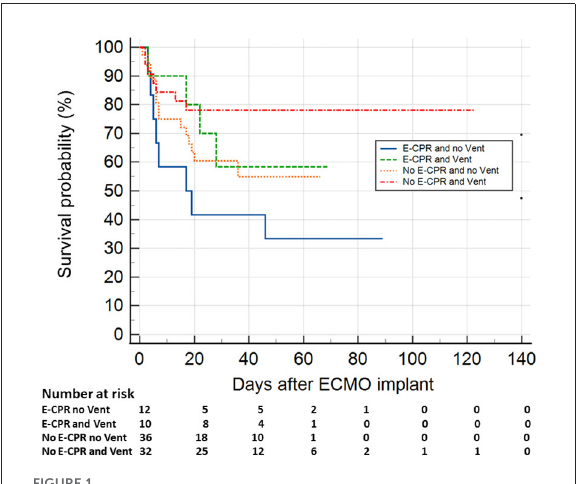
FIGURE1 Survival in pediatric patients supported with V-A ECLS, based on the presence/absence of E-CPR and LV unloading strategy. The function showed a significant higher survival ( p = 0.012) in patients without E-CPR and receiving venting compared to those undergone to E-CPR and who had no LV unloading (hazard ratio 3.6, 95% confidence interval 1.18–11.0). E-CPR,